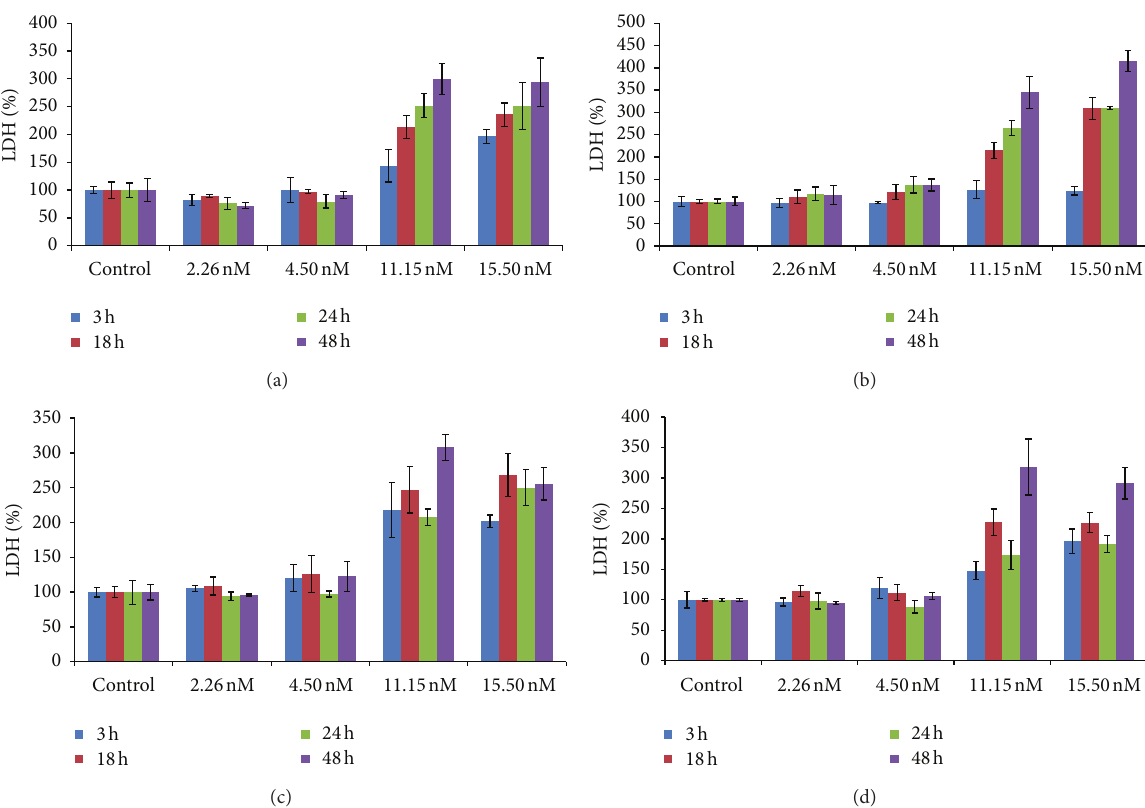
Figure 6: Time and concentration dependence of neurotoxicity induced by trimeric rhTau (1N4R and 2N4R) toward neuroblastoma cells measured by LDH assay. Nondifferentiated SH-SY5Y cells incubated with (a) 1N4R tau and (b) 2N4R tau; retinoic-acid-differentiated SH- SY5Y cells incubated with (c) 1N4R tau and (d) 2N4R